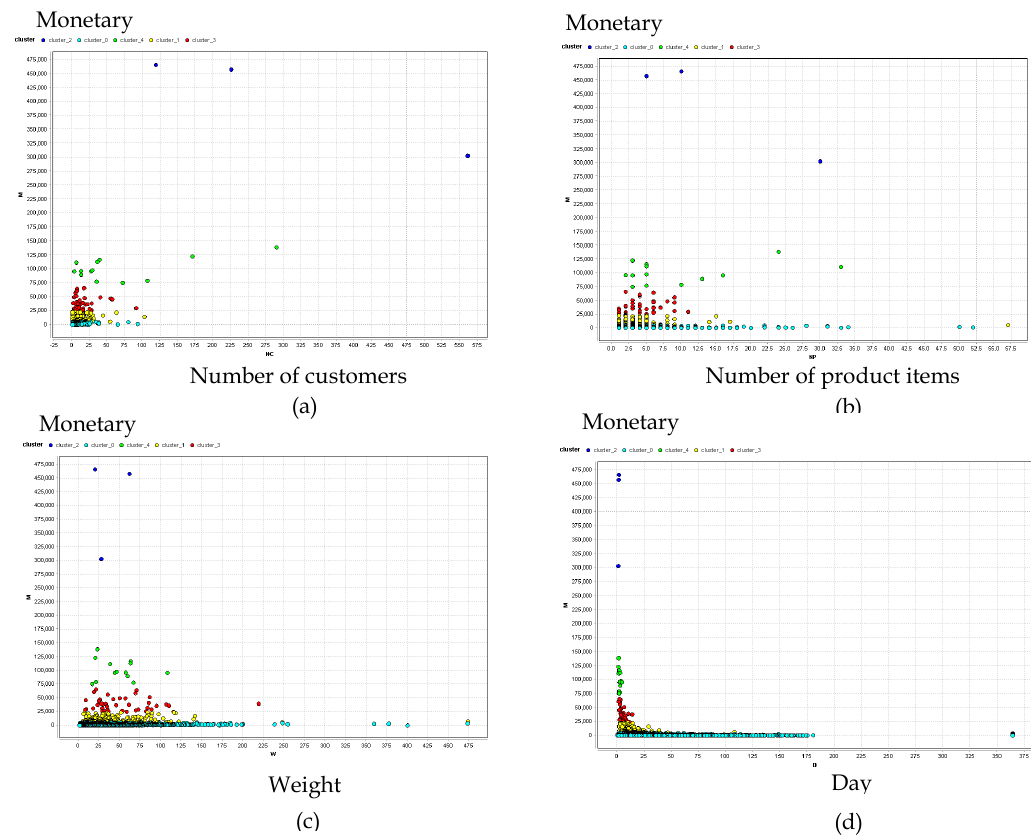
Figure 6. Scatter plots of clothes shipper clusters for the following variables: ( a ) monetary/number of customers ( b ) monetary/number of product items ( c ) monetary/weight ( d ) monetary/day.